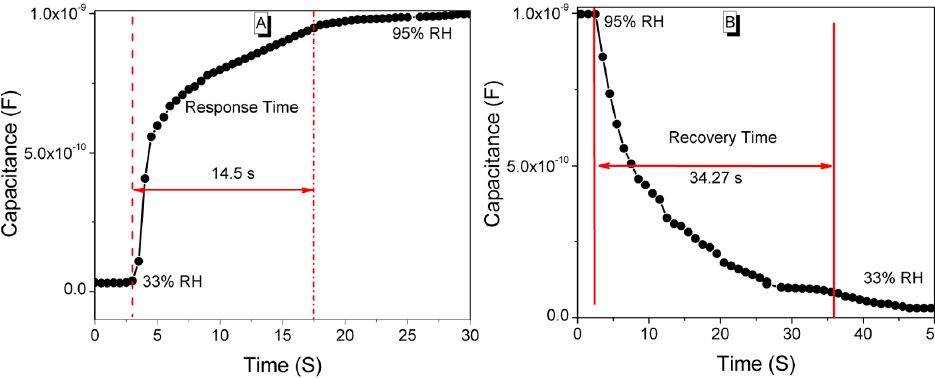
Figure 11. Response and recovery times of the CMFTO humidity sensors for humidity levels between 33% RH and 95% RH at 10 2 Hz. ( A ) Response time (14.5 s); ( B ) Recovery time (34.27 s).